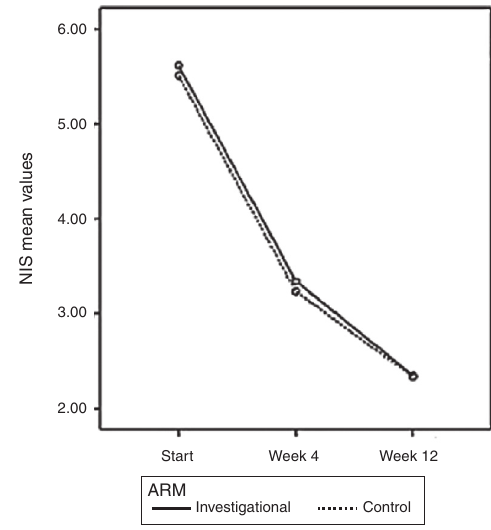
Total NIS score over time based on patient diary, PP population ( n = 308).